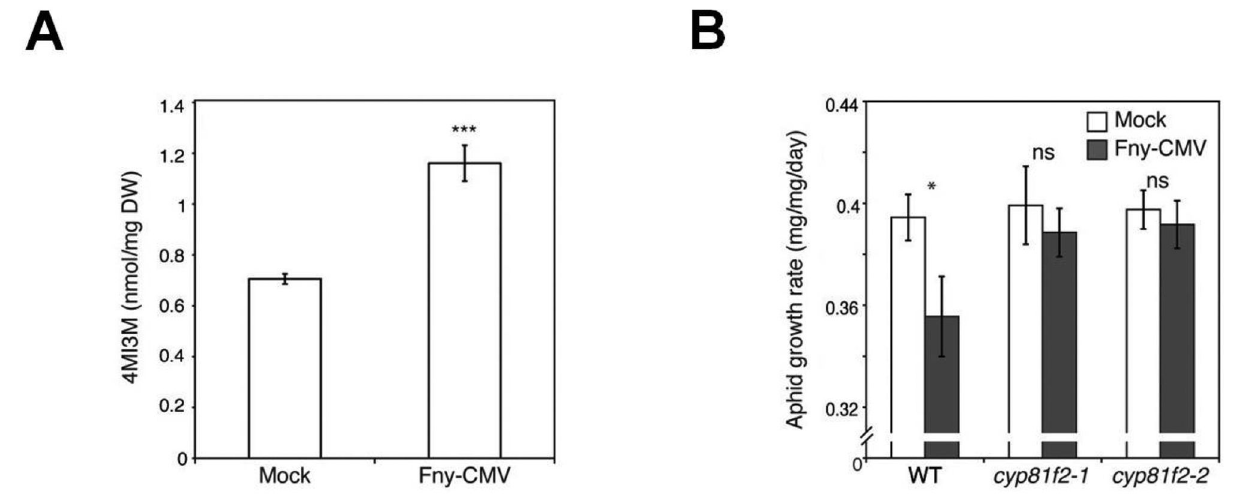
Figure 5. Fny-CMV infection of Arabidopsis induces resistance to aphids by inducing accumulation of 4-methoxy-indol3yl- methylglucosinolate (4MI3M). (A) High performance liquid chromatography analysis showed that Fny-CMV infection induced accumulation of the anti-feedant glucosinolate, 4MI3M. (B) Fny-CMV infection was unable to induce resistance in either of two independent cyp81f2 mutant lines compromised in 4MI3M biosynthesis contrary to wild-type (WT) plants, n≥24. Error bars represent standard error of the mean. Asterisks indicate significant differences [Student’s t -test in (A), ANOVA with post-hoc Tukey’s tests in (B)]: *, P <0.05; **, P <0.01; ***, P <0.001. Non-significant: ns. doi: